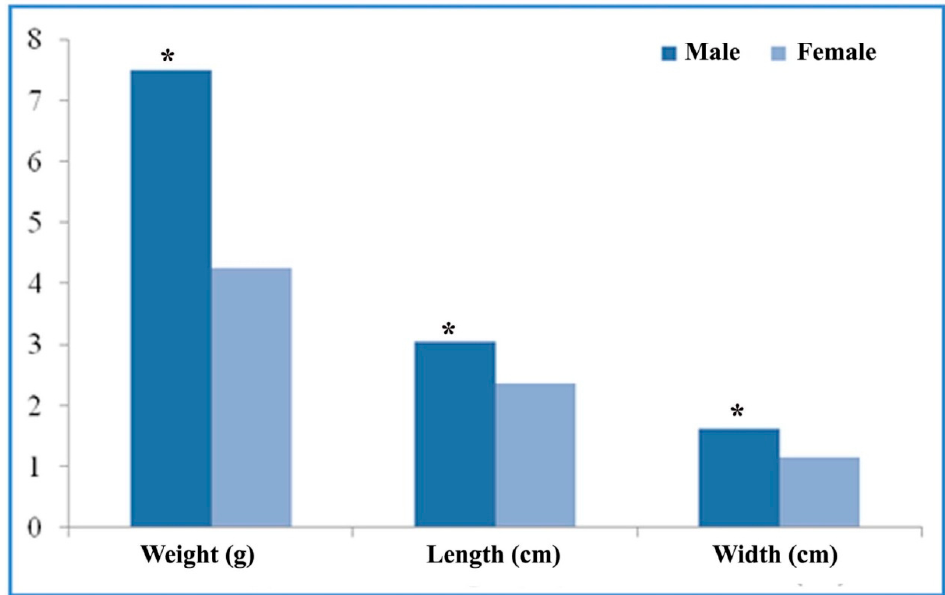
Figure 3. Mean values of the morphometric parameters (length, width, and weight) of male and female interdigital glands (CG). * p < 0.05, male gland compared to female gland.